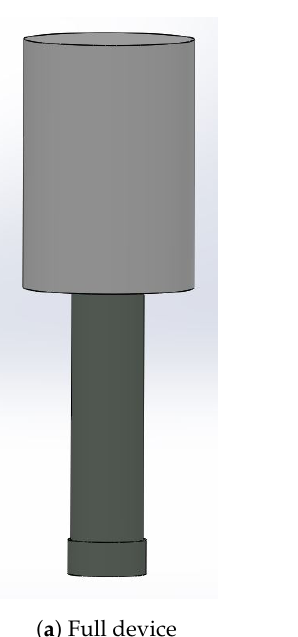
Figure 4. 3D design of the full-scale Tupperwave device implemented in the CFD